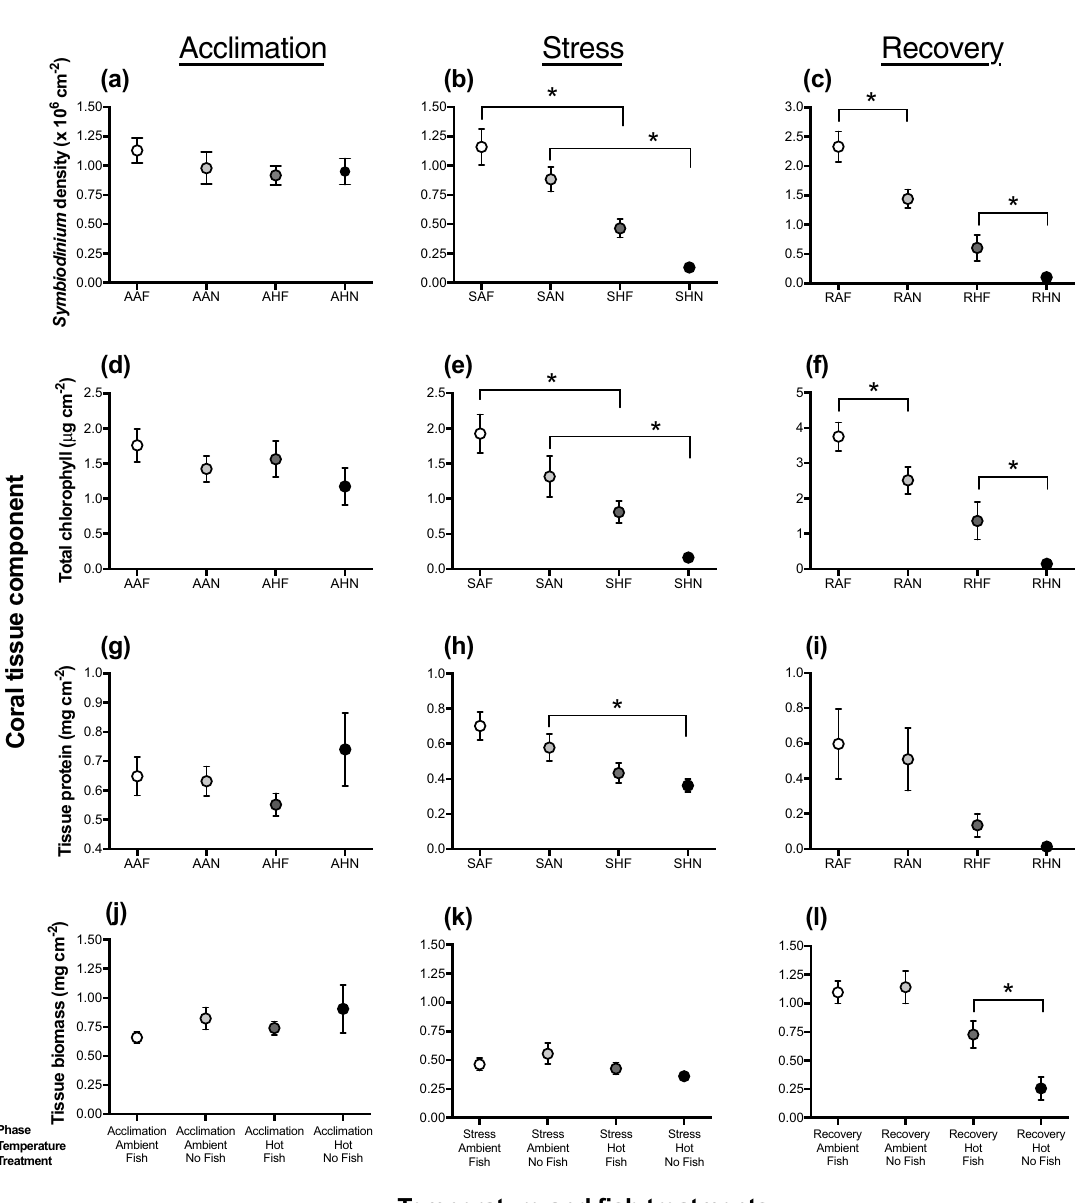
Fig 3. Levels of (a-c) endosymbionts ( Symbiodinium density x10 6 cm -2 ), (d-f) total chlorophyll (chl a + chl c , μ g cm -2 ), (g-i) protein (mg cm -2 ), (j-l) tissue biomass (calculated via grams of ash-free dry weight mg cm -2 ) in experimental P . damicornis colonies, with D . aruanus for different temperature and fish treatments (ambient/fish: n = 9, ambient/no fish: n = 9, hot/fish: n = 10 and hot/no fish: n = 9) for three different experimental phases (Acclimation (25˚C), Stress (temperature increased and held at 32˚C for four weeks), and Recovery (temperature returned to 25˚C). ( � ) denotes a significant difference between select comparisons fish treatments, and error bars show S.E. Refer to S6 Table for results of all 12 planned contrast per coral tissue components. Note difference in y-axis for panels C and F, to allow for visualization of variance between treatments. Data points per phase, temperature, and fish presence have been abbreviated to form 3 letter keys, as follows: A = acclimation, S = stress, R = recovery, A = ambient temperature, H = hot/bleaching temperature, F = fish present, N = fish absent. i.e. SHF = sample collected during stress phase of a hot temperature with fish present